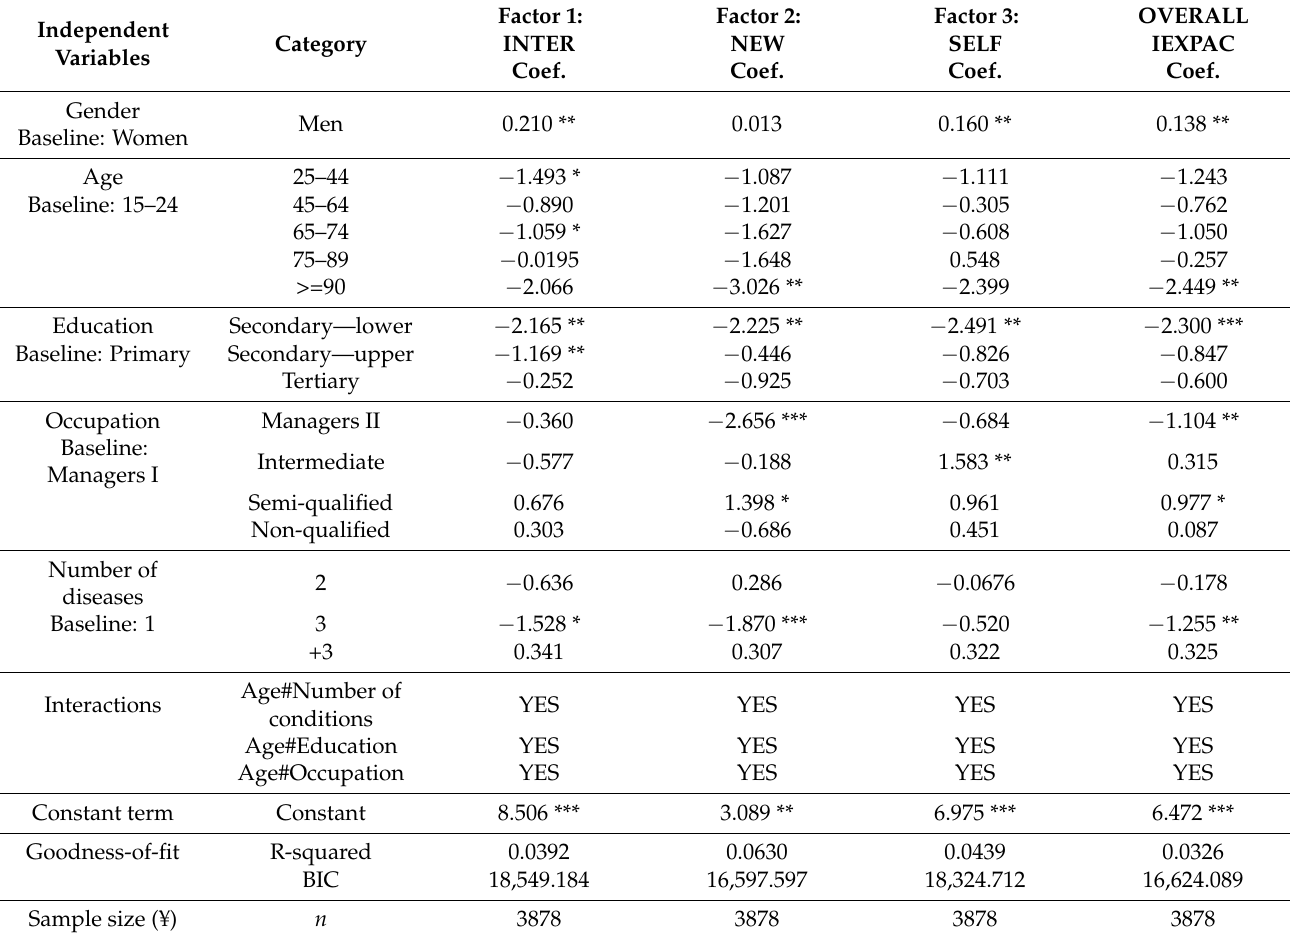
Table 4. Model 2—WLS results. Differences in health care experience among patients with self-declared chronic conditions. The effect of chronic